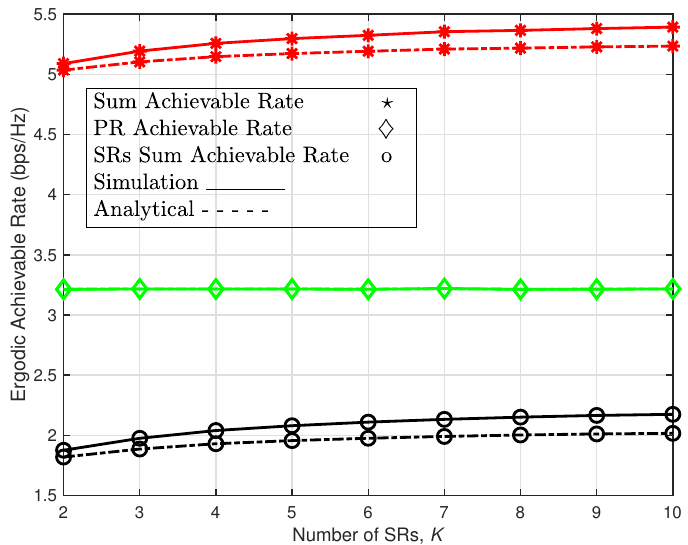
Figure 5. Ergodic achievable rate performance versus the number of SRs, K